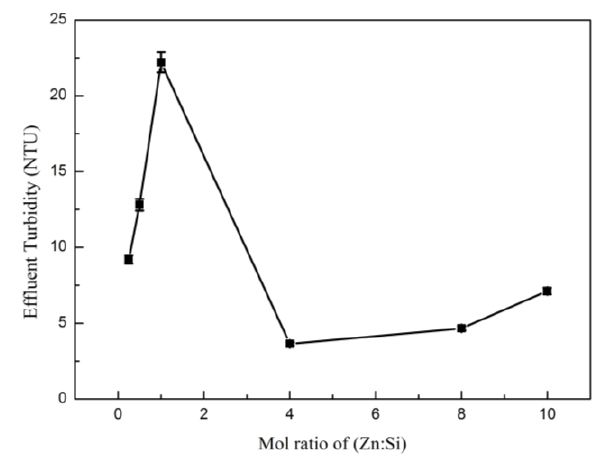
Figure 7. Effect of nZn:nSi on the Zn-PSAFS removal of turbidity.